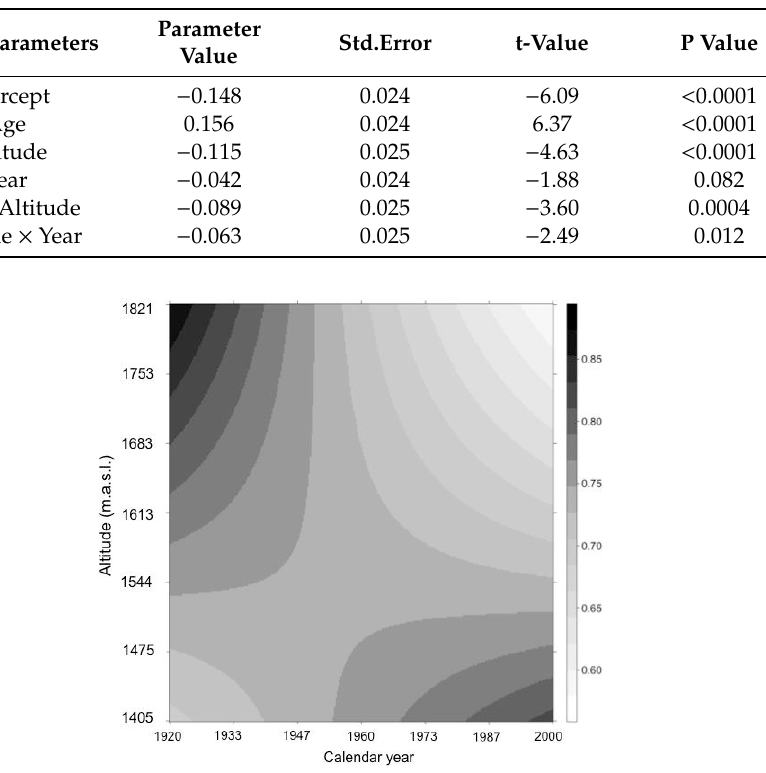
Figure 4. Contour plots showing tree growth responses (cm 3 ) to pair-wise interactions over the tree age and the altitude gradient.